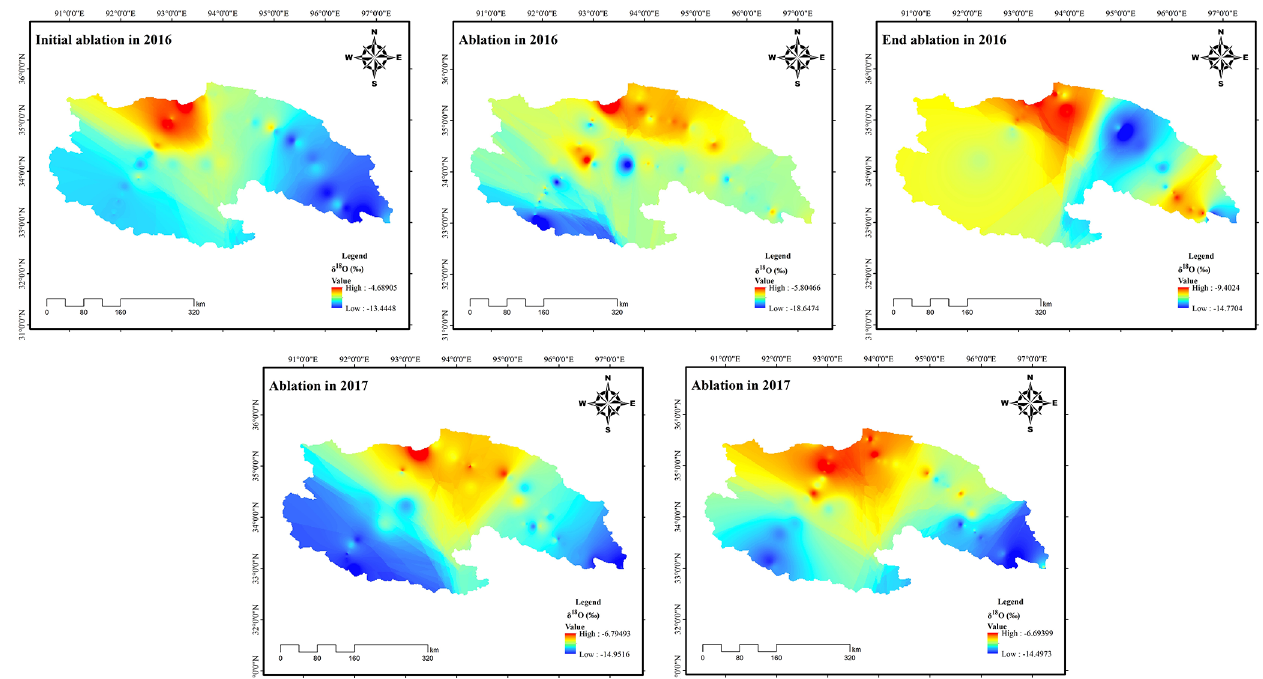
Figure 3. Spatial variation in δ 18 O based on different ablation in 2016 and ablation from 2016 to 2018.